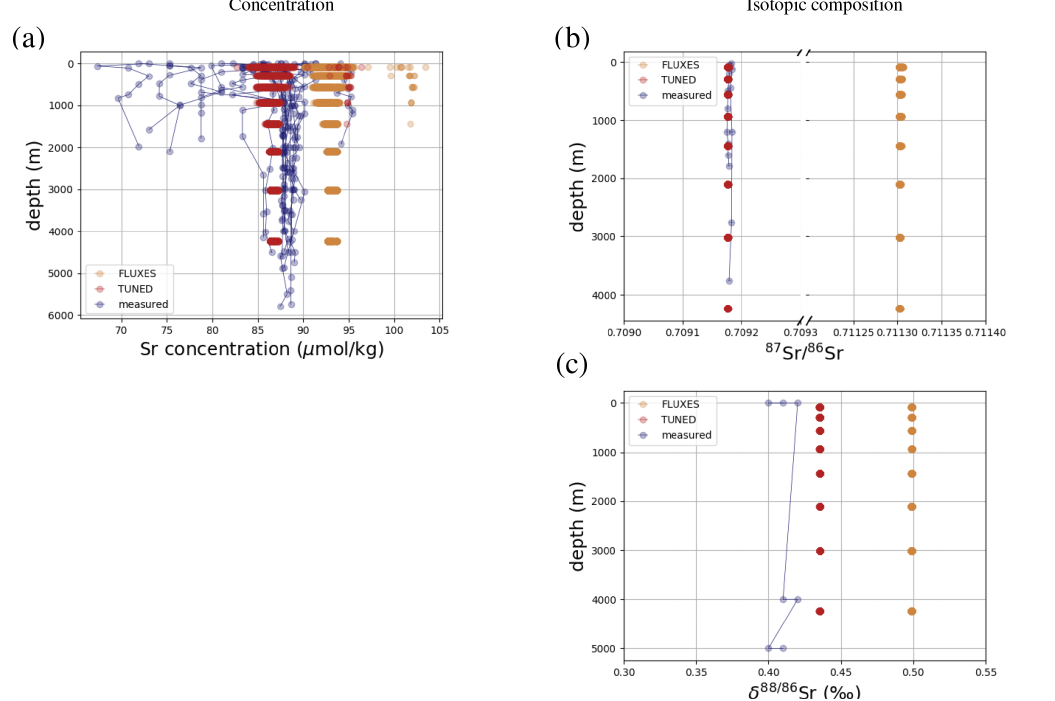
Figure F5. Comparison between measured and simulated Sr profiles in seawater. Composites of all available measured Sr concentration (a) and isotope ratio (b, c) profiles and all profiles in the simulation are shown. Data are taken from Angino et al. (1966), Fabricand et al. (1967), Bernat et al. (1972), Brass and Turekian (1974), De Villiers (1999), and Mokadem et al. (2015). Sr concentrations are normalized to a salinity of